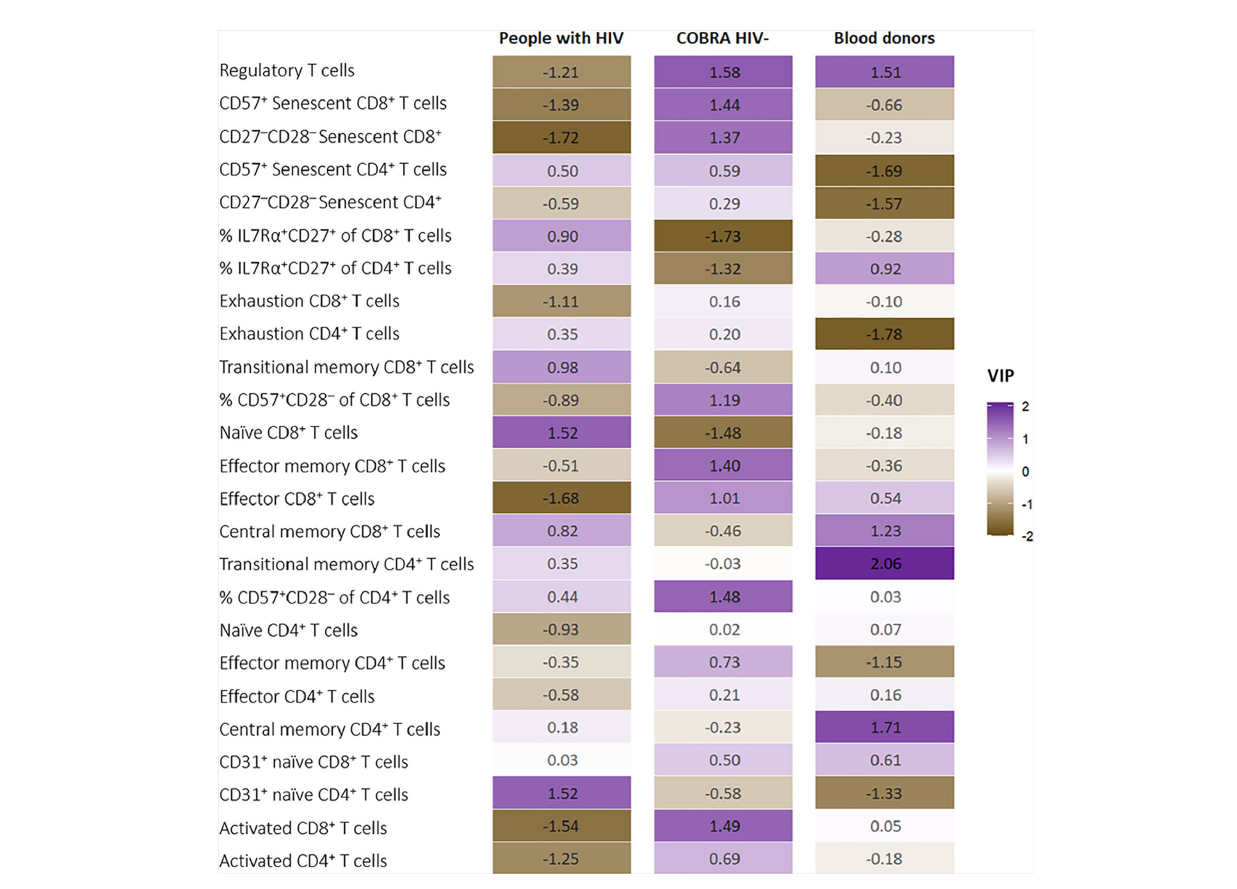
FIGURE 5 | Variable Importance in Projection (VIP) values for the T cell markers in the partial least squares regression (PLSR) run separately in people with HIV (n=40), COBRA HIV-negative individuals (n=40) and blood donors (n=35). VIP scores are color-coded ranging from brown for a negative VIP to purple for a positive